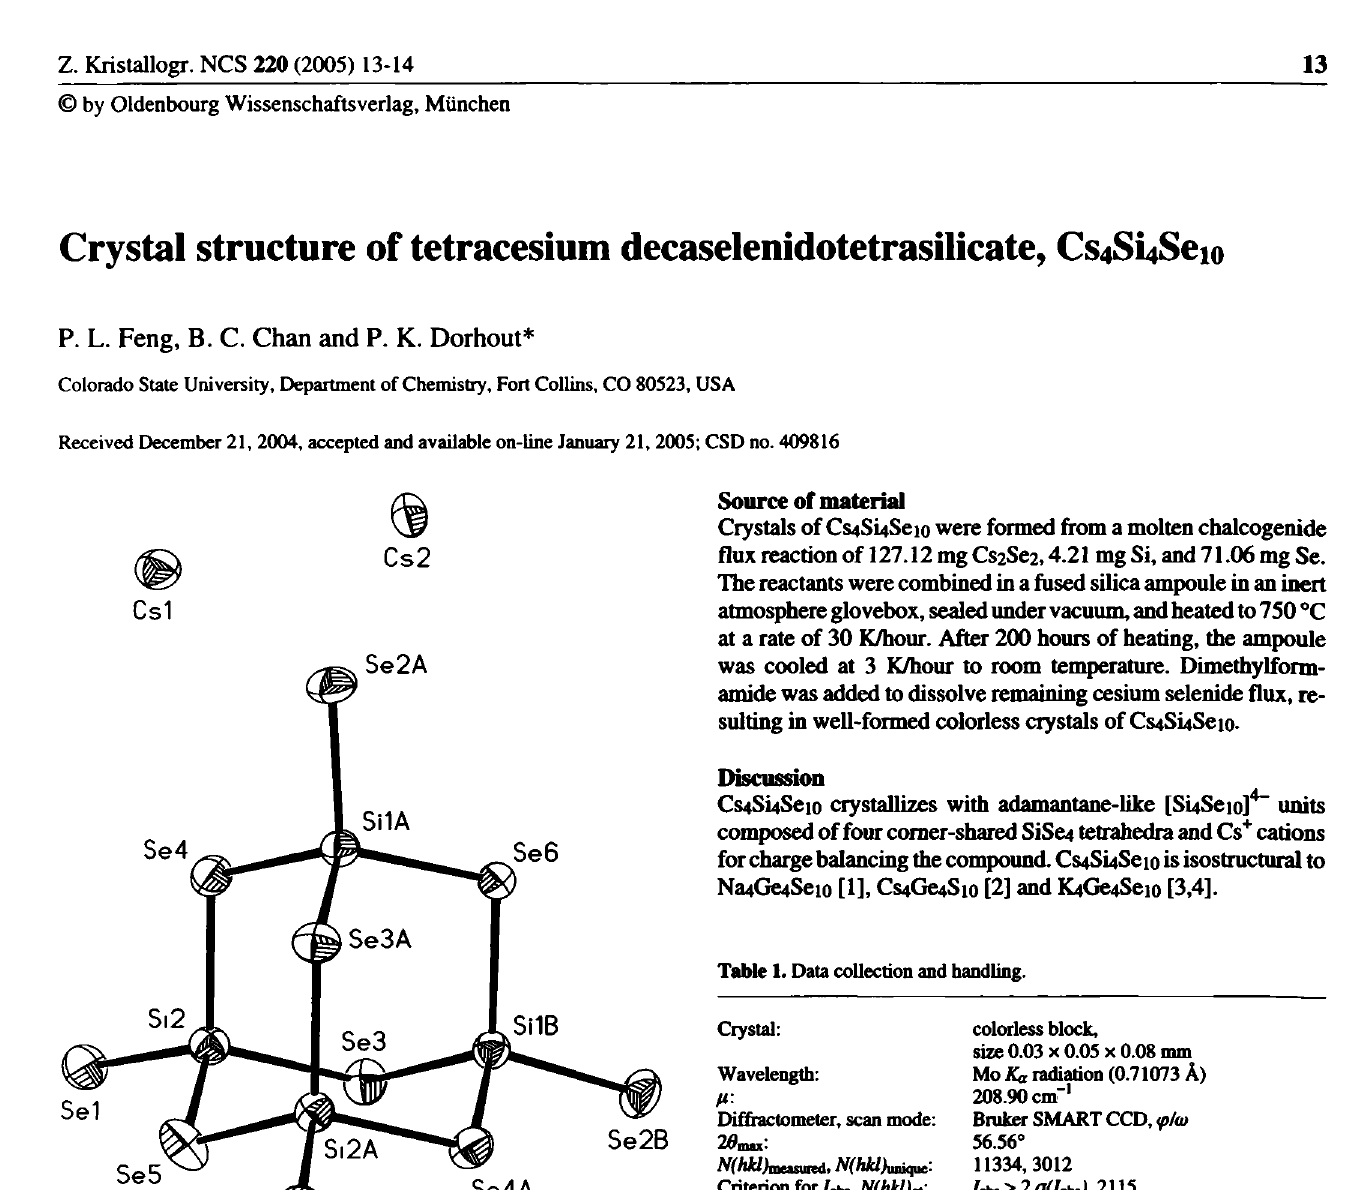
Table 2. Atomic coordinates and displacement parameters (in Ä 2